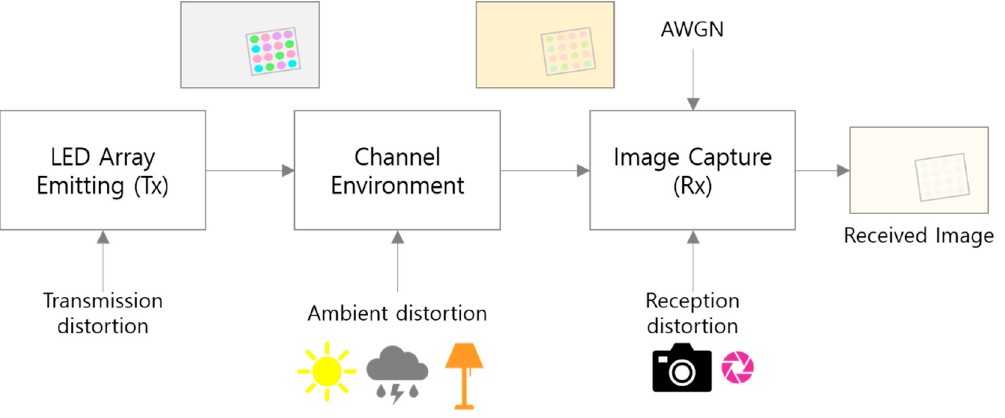
Figure 8. real-world channel distortion factors in visual MIMO systems. Figure 8. Real-world channel distortion factors in visual MIMO